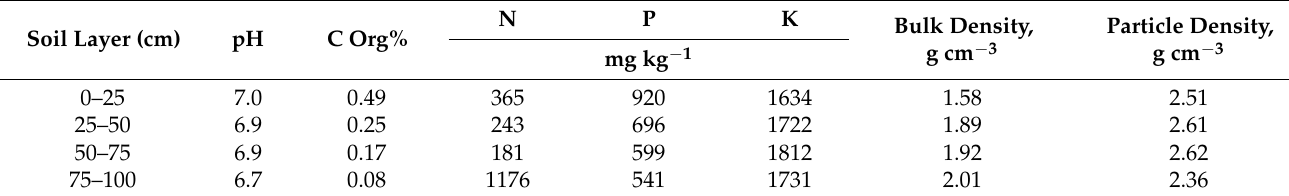
Table 2. Physical and chemical properties of investigated